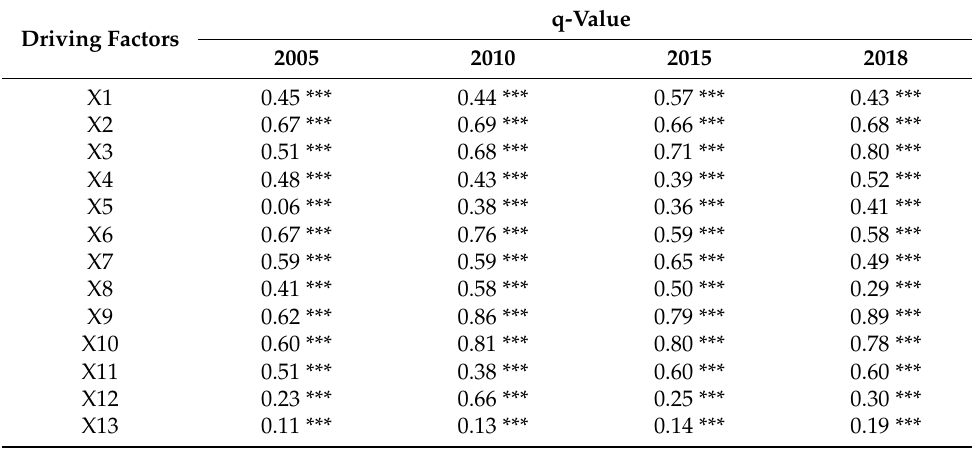
Table 4. Driving factors detection